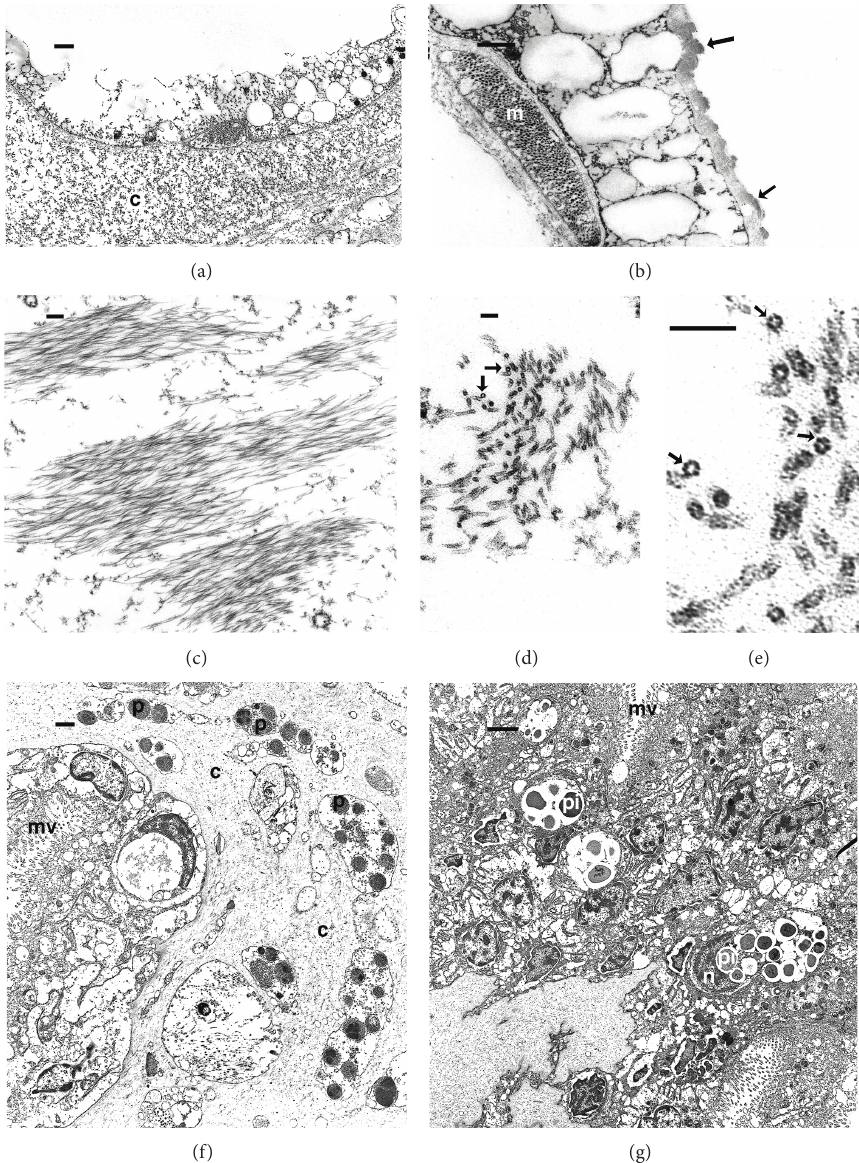
Figure 7: Transparent vesicle of Dolabrifera dolabrifera ((a)–(e)) and the epidermis of its ink gland ((f) and (g)). ((a) and (b)) The electron- lucent lumen is surrounded by a thin layer of cytoplasm against which electron dense material (arrows) is deposited. ((c)–(e)) Arrays of filaments with translucent cores (arrows in (d)) and a wall composed of subparticles (arrows in (e)) were occasional found free in the vesicle lumen. ((f) and (g)) Cells below the epidermis containing protein (f) or pigment granules (g). c, connective tissue; m, muscle; mv, microvilli; n, nucleus; p, protein granule; pi, pigment granule. Scale bars: (a) and (b) = 1 𝜇 m; (c) = 200 nm; (d) and (e) = 50 nm; (f) = 1 𝜇 m; (g) = 2 𝜇 m.